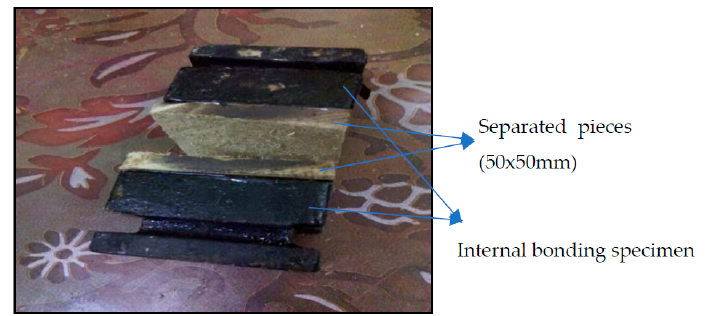
Figure 4. Internal bonding specimen.